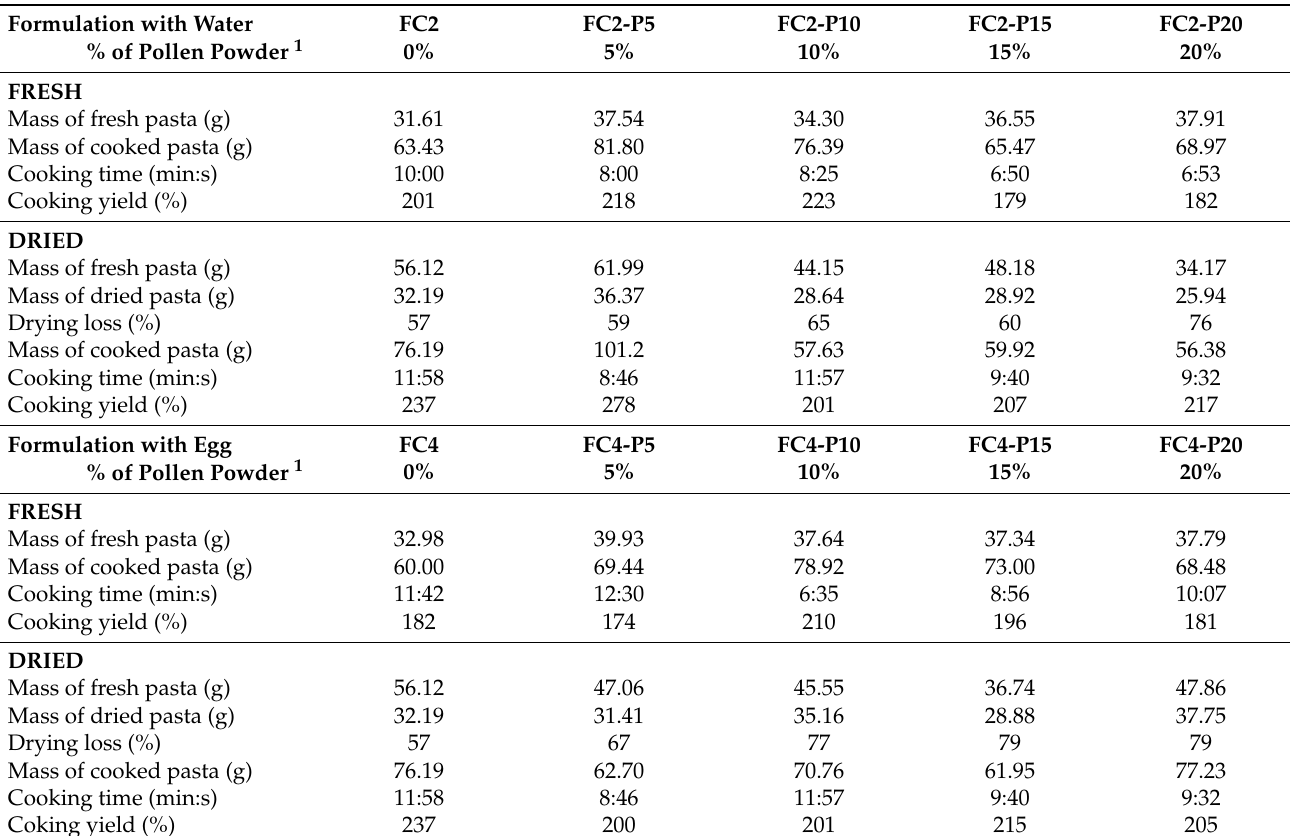
Table 6. Experiments for pasta containing water or egg plus pollen powder at variable percentages.